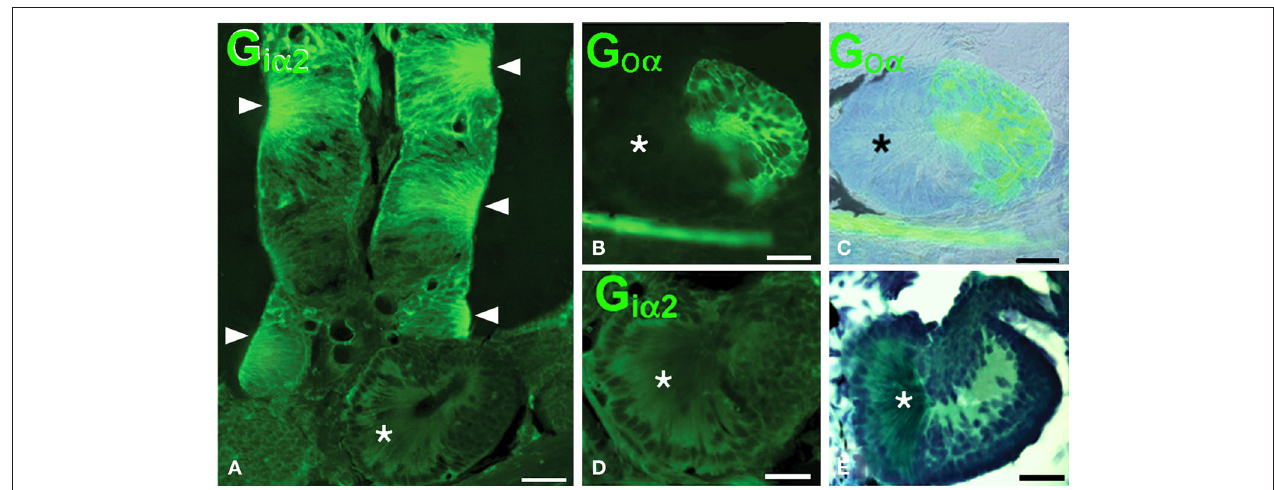
(asterisk). (B–D) The basal crypts are mixed structures with a Go α -positive part (B,C) that is Gi α 2-negative (D) and a distinct part that lacks both reactivities (asterisks; e ,